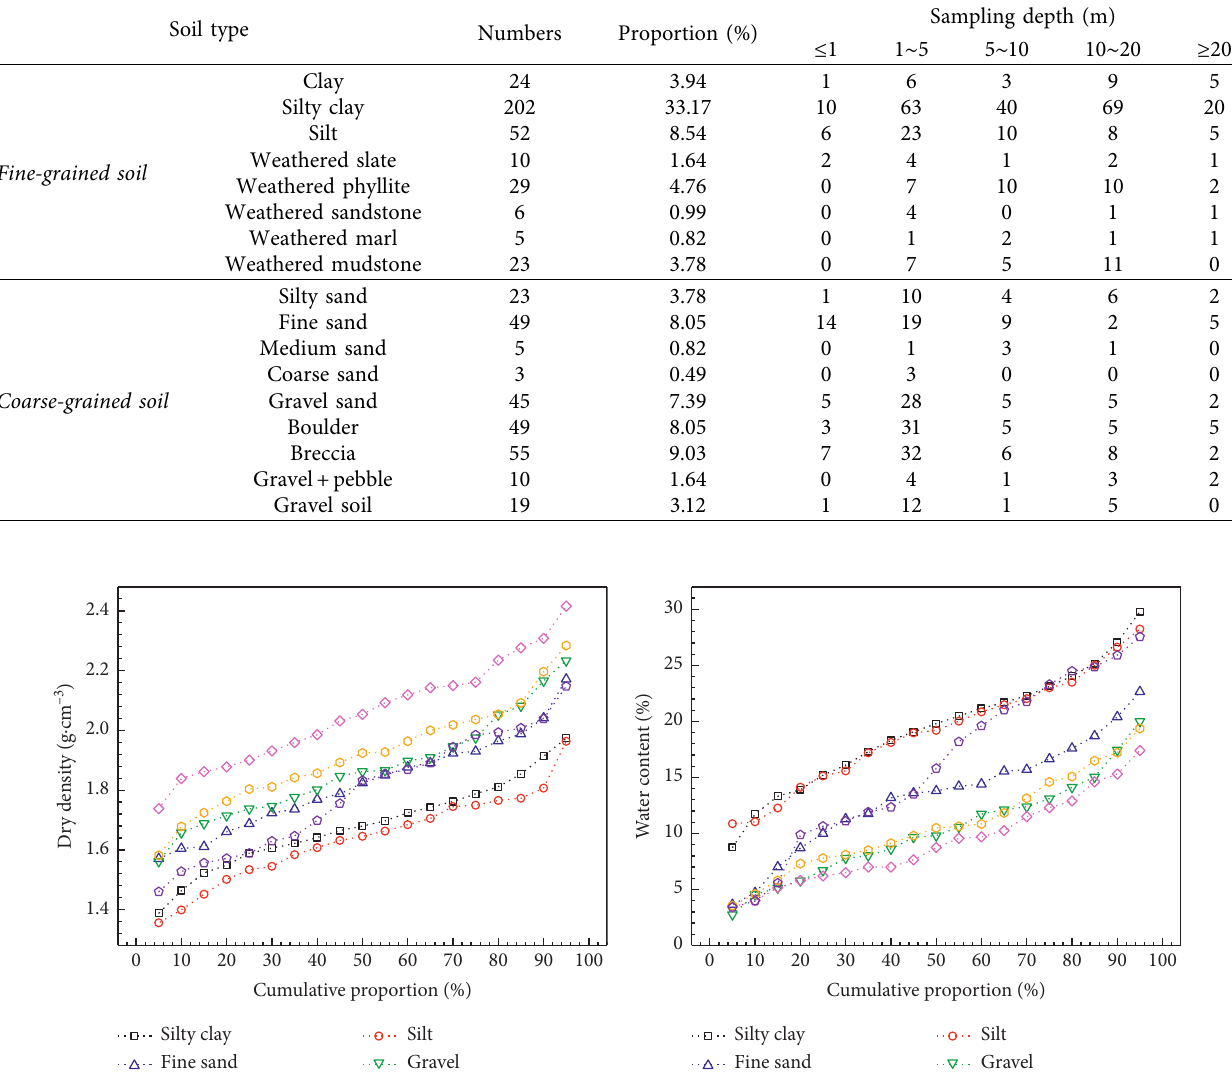
Table 1: Statistical distribution of various soil specimens.